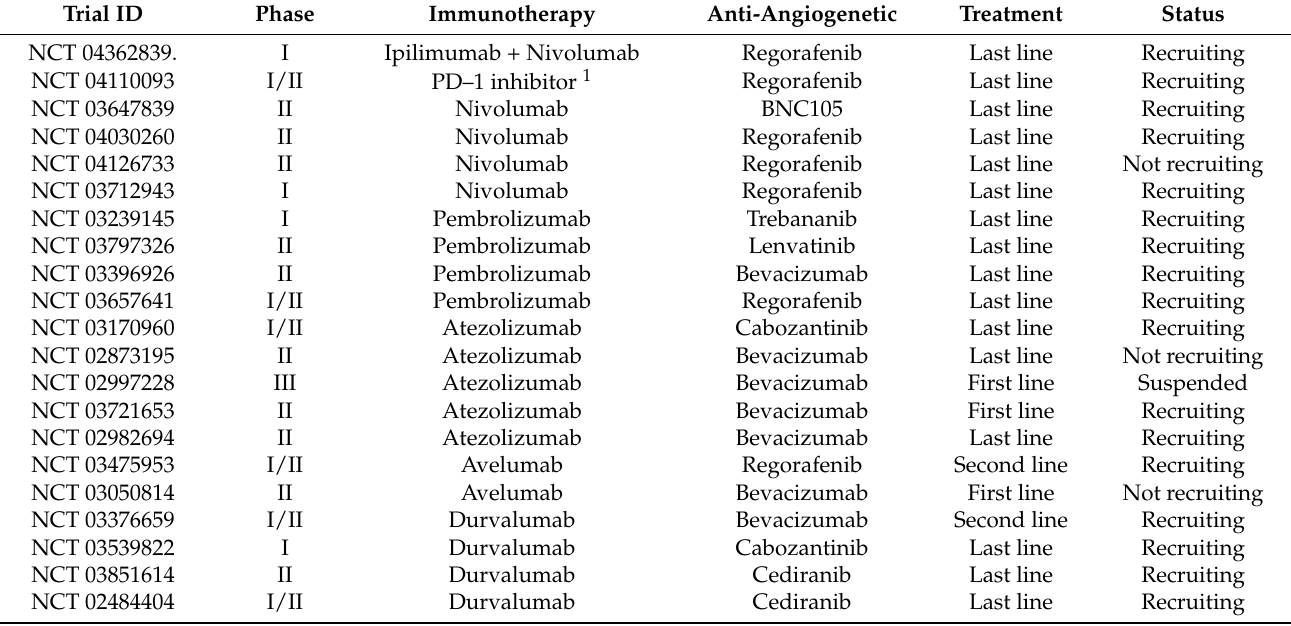
Table 6. Ongoing clinical trials in metastatic colorectal cancer combining immunotherapy and anti-angiogenetic treatment. Trial ID